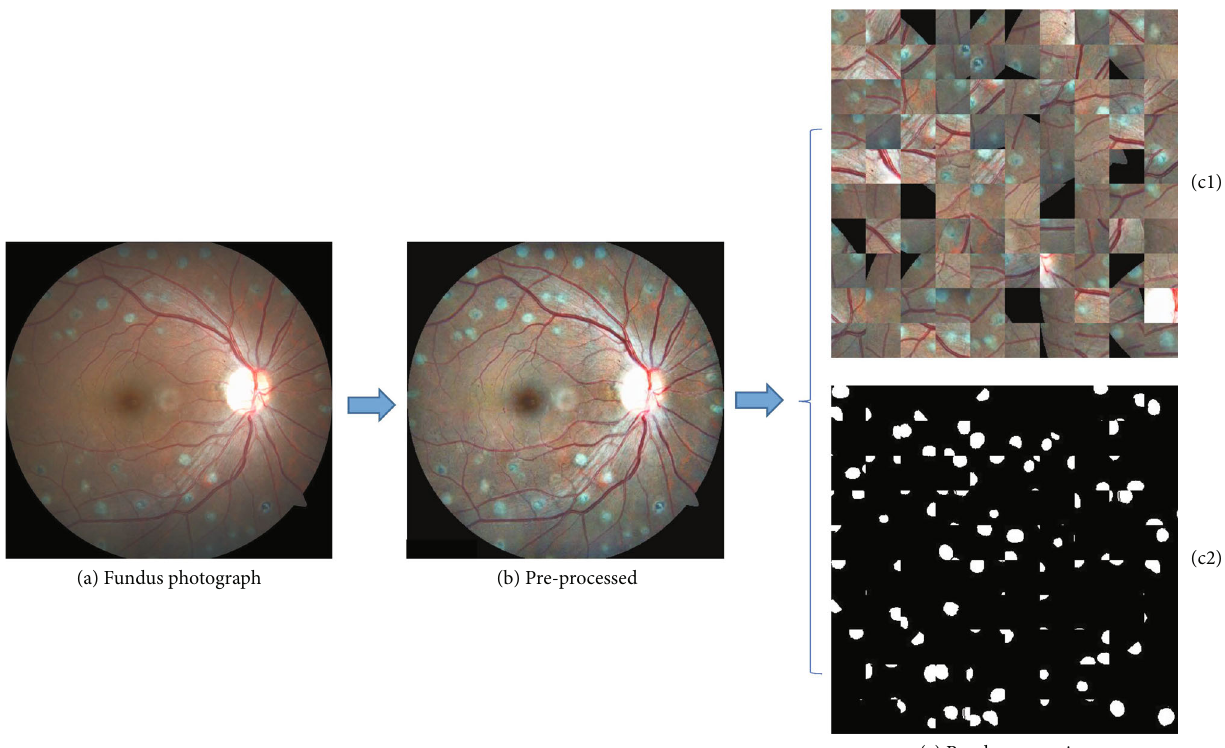
Figure 1: Presentation of the preprocessing and data augmentation session. (a) A sample from the training set. (b) The matching preprocessed image. (c) The examples of the randomly cropped patches (c1) and the corresponding labeled patches